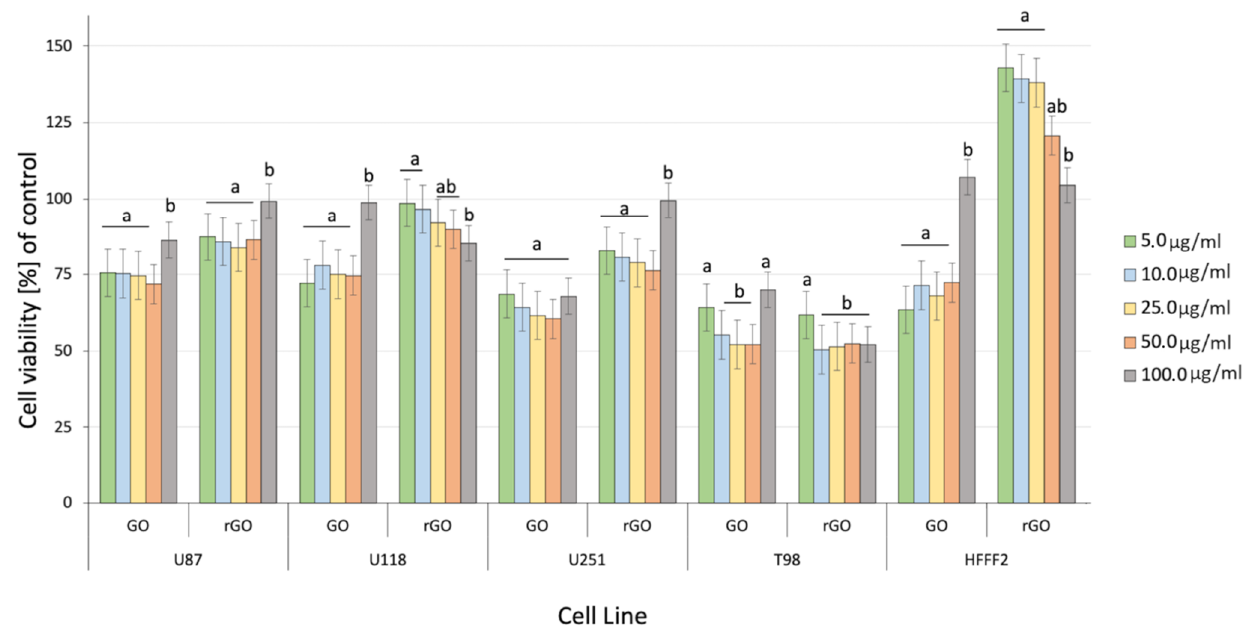
Figure 4. Effect of graphene oxide (GO) and reduced graphene oxide (rGO) on U87, U118, U251 and T98 GBM cell lines and HFFF-2 human fibroblast viability. Bars represent the means with standard deviation (SD) ( n =3). Notes: Different lowercase letters (a and b) within columns indicate significant differences between the concentrations ( p < 0.05). Abbreviations: GO: graphene oxide and rGO: reduced graphene oxide.